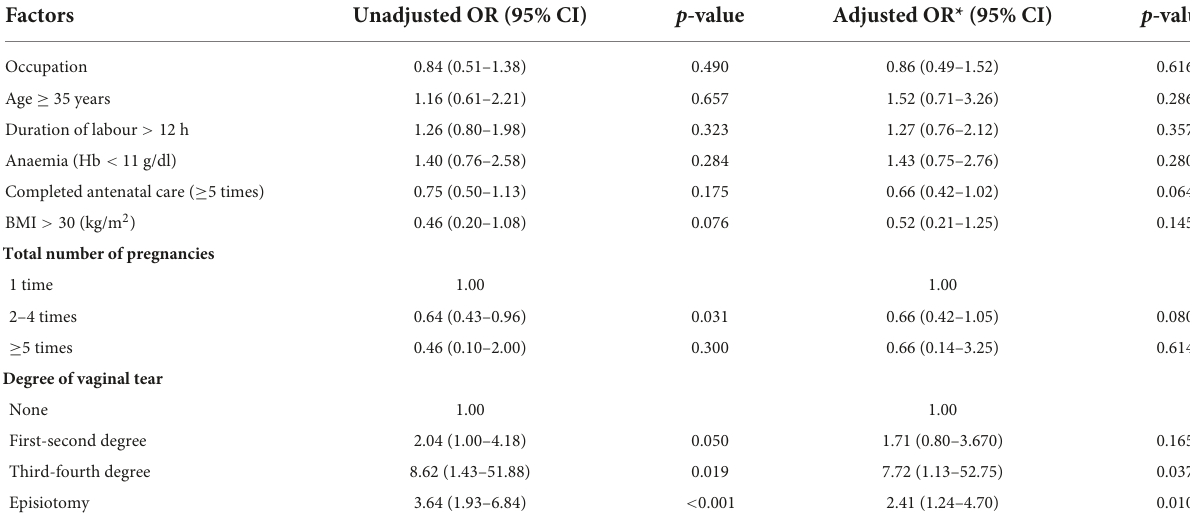
TABLE 3 Factors associated with antibiotic prescribing for postpartum infection prophylaxis among women with normal vaginal